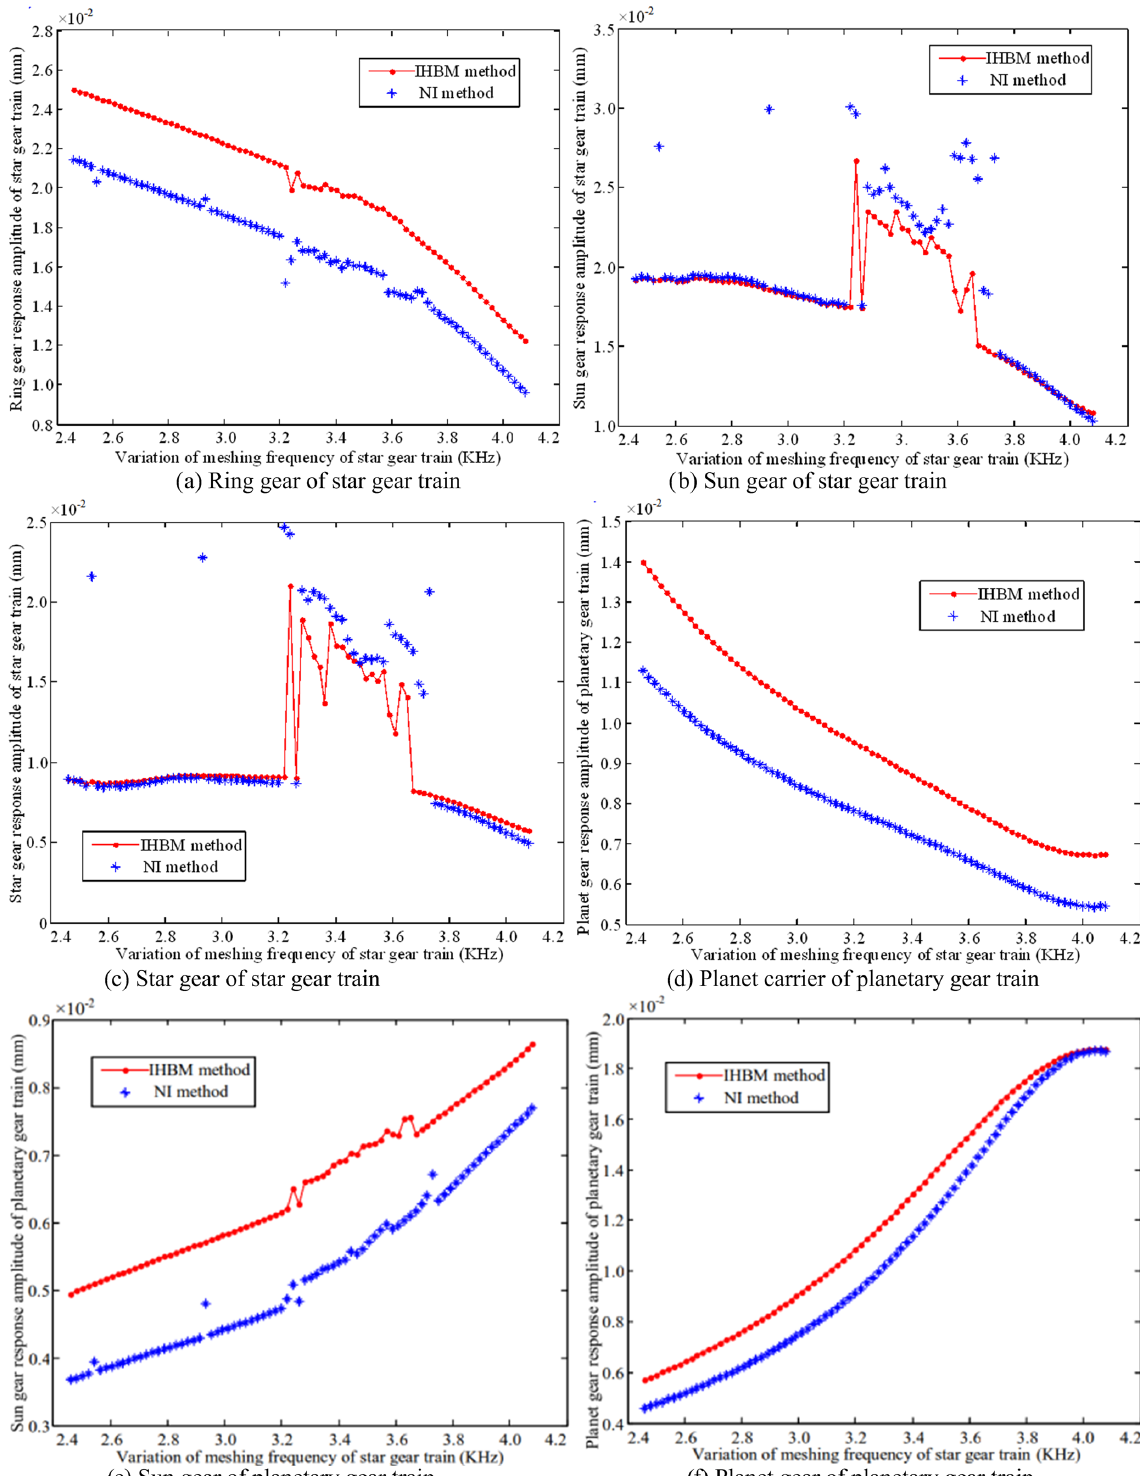
Figure 4. Variation of the torsional response amplitude of each component of the PGS using the IHB method.